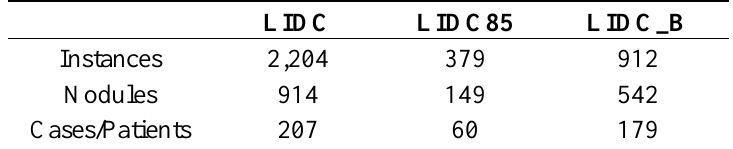
Table 4. LIDC datasets overview; LIDC_B is a balanced data